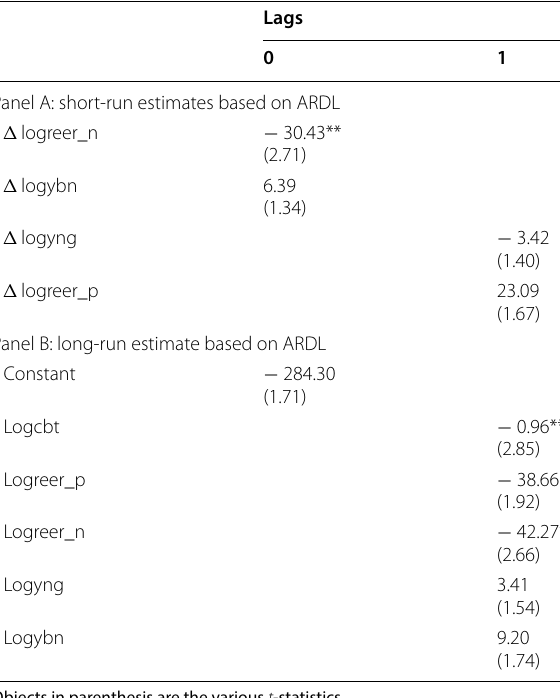
Panel A: short-run estimates based on ARDL